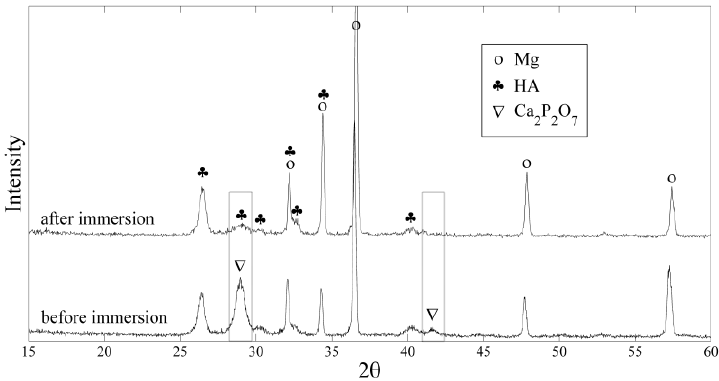
Figure 6. Comparison between the XRD patterns of HA coating before and after immersion test.